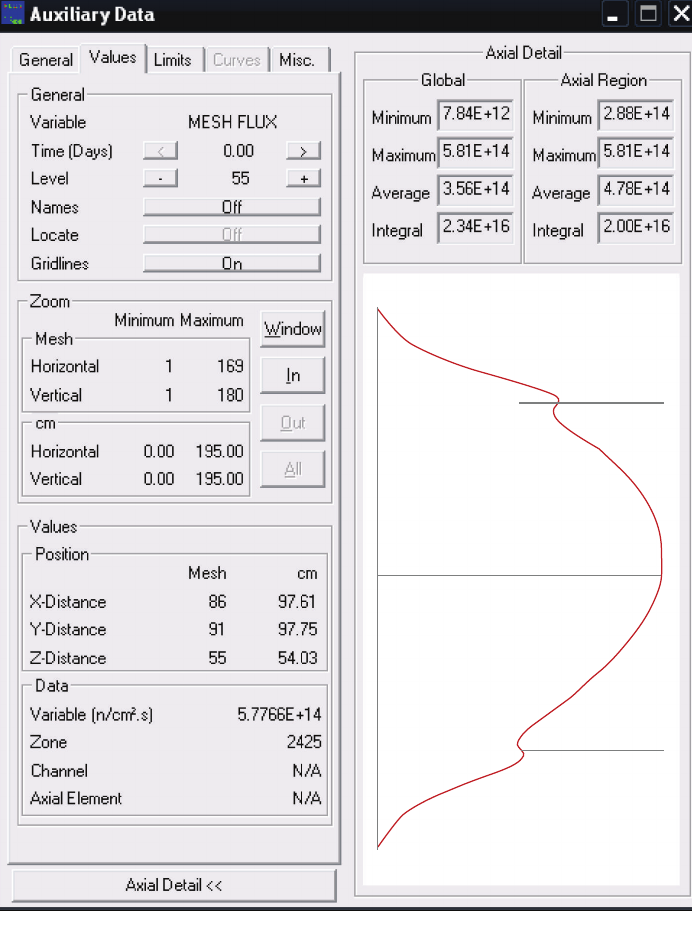
Figure 7: FLUX’s auxiliary data child